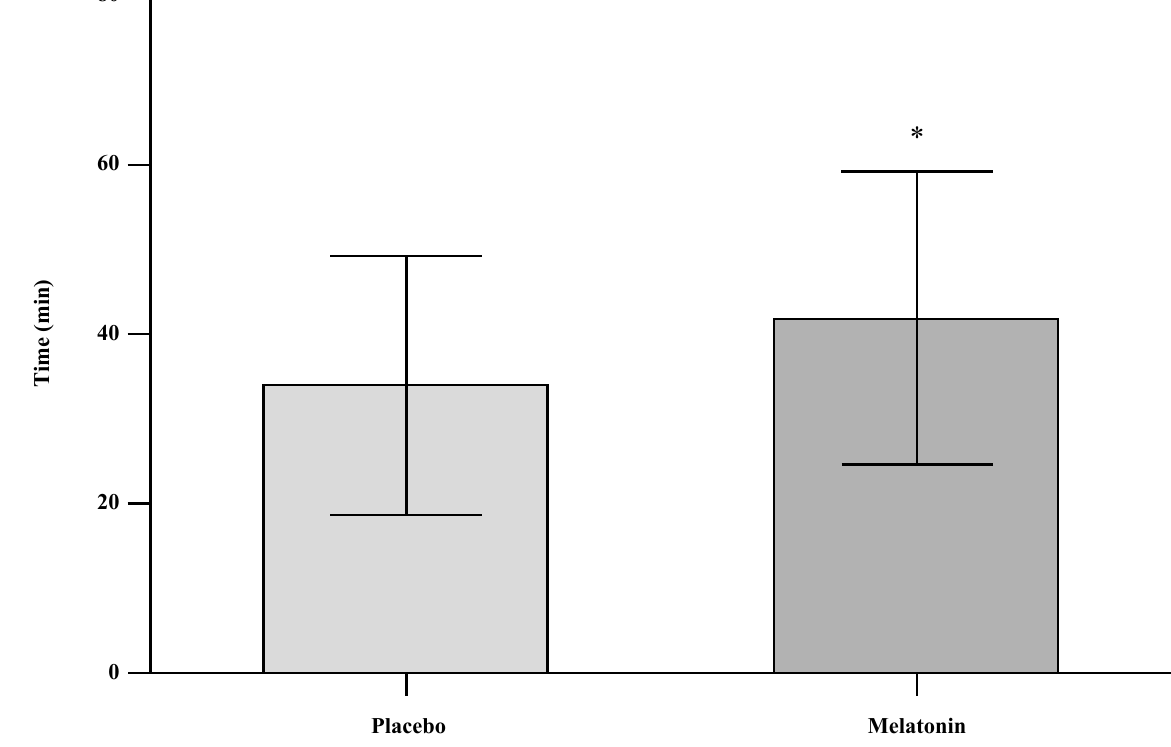
Figure 1. Time to exhaustion at maximal aerobic capacity intensity performed with placebo or melatonin. * p = 0.03 in relation to placebo.